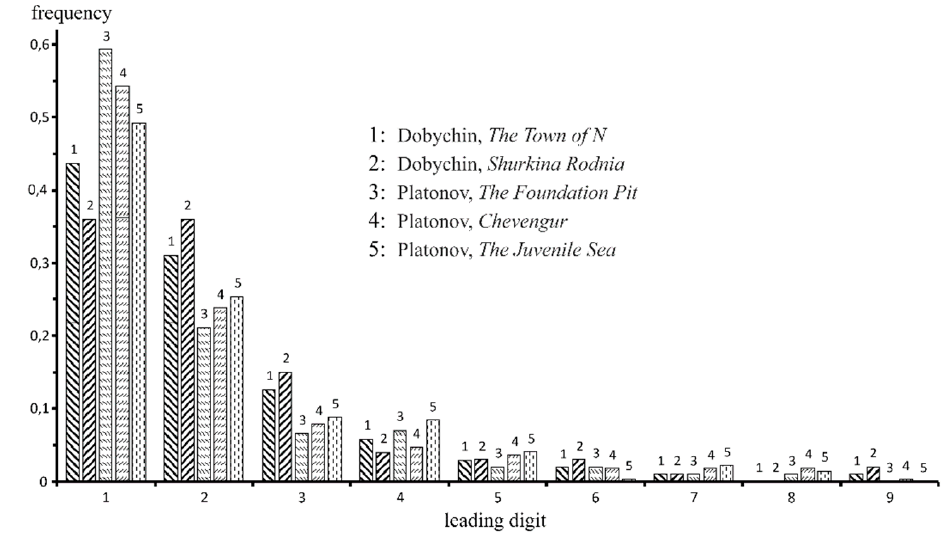
Figure 11. Distribution of relative occurrence frequencies of the first significant digits of numerals in the texts by L. Dobychin and A. Platonov.